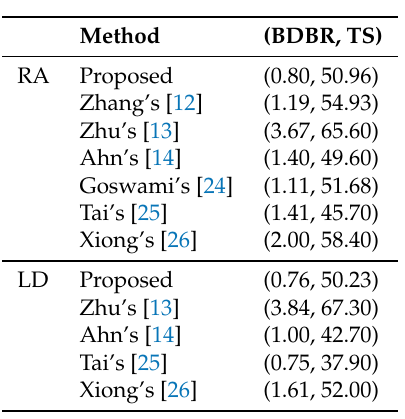
Figure 11. Time savings of the proposed method for “Cactus” and “BlowingBubbles”. Table 6. Performance comparison of the proposed method compared to previous